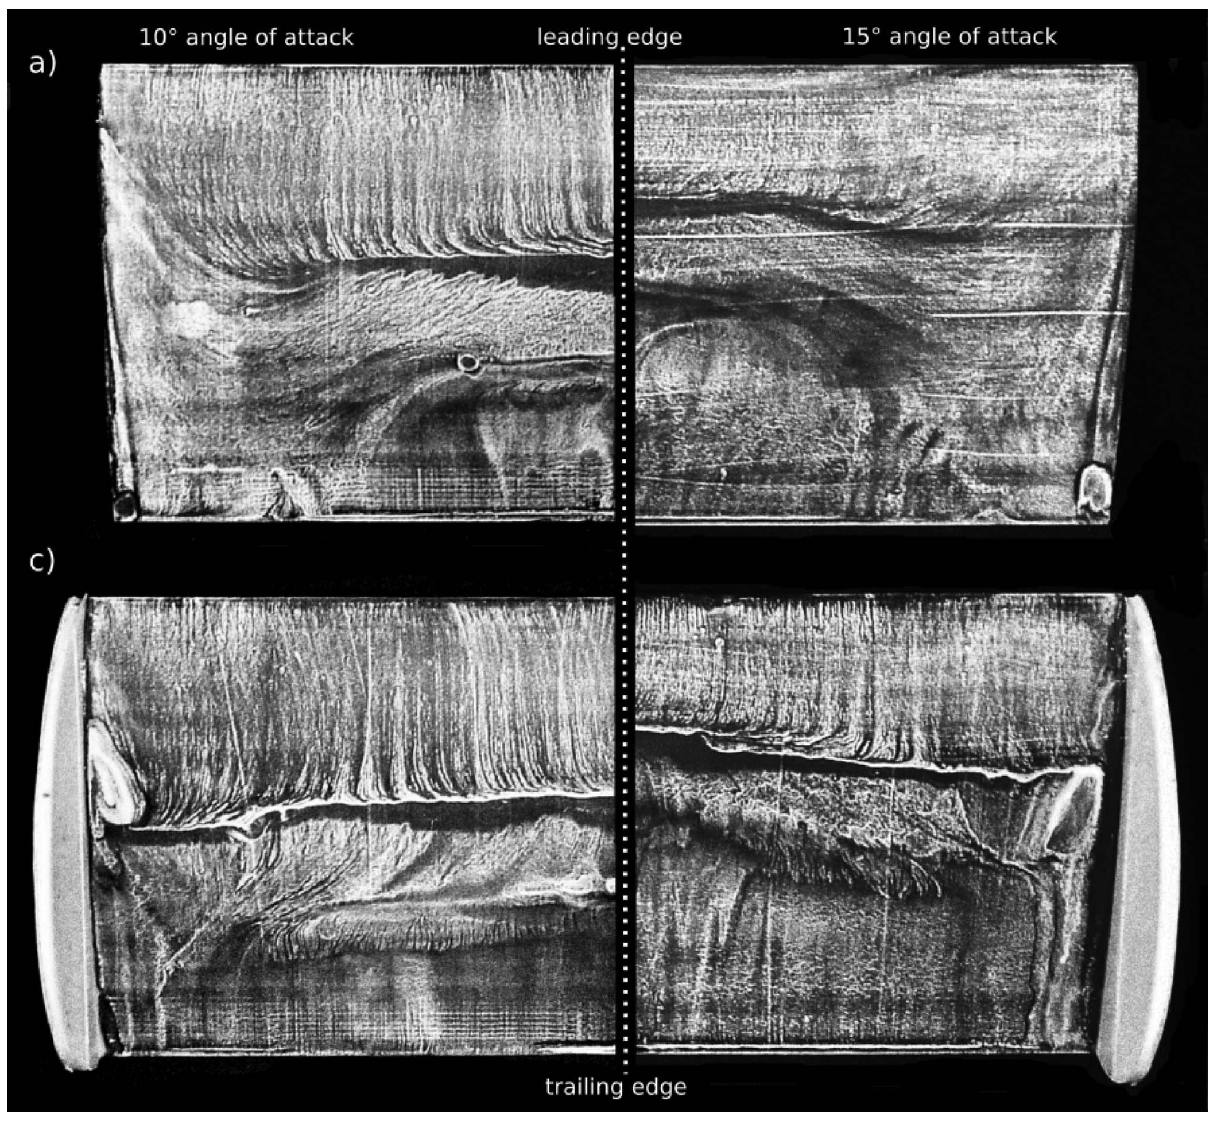
Figure A2. Surface fl ow visualization suction side NACA 4412 for Re = 150,000 and 10 (cid:1) (left) and 15 (cid:1) angle of attack (right), pictures are cut at half span and mirrored, fl ow from top to bottom, left side wall, right side free end, top: (a) baseline con fi guration, bottom: (c) end plate on the suction